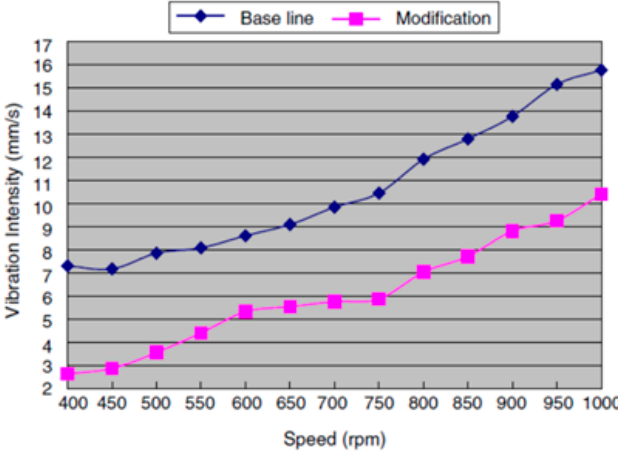
Figure 13. Modal density comparison of the original vs. modified engine designs [28]. Figure is reprinted with permission from publisher.